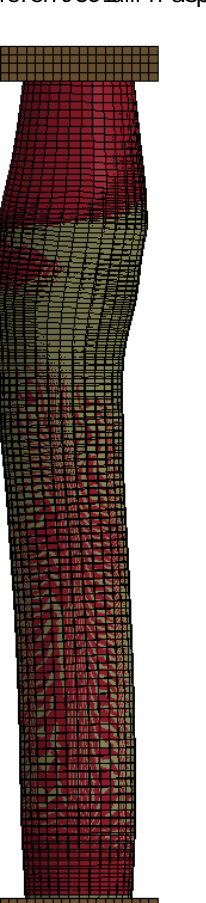
Figure 10. Axial strain-normalized strength relationship of CFFT with LRS-FRP with different column aspect ratios.